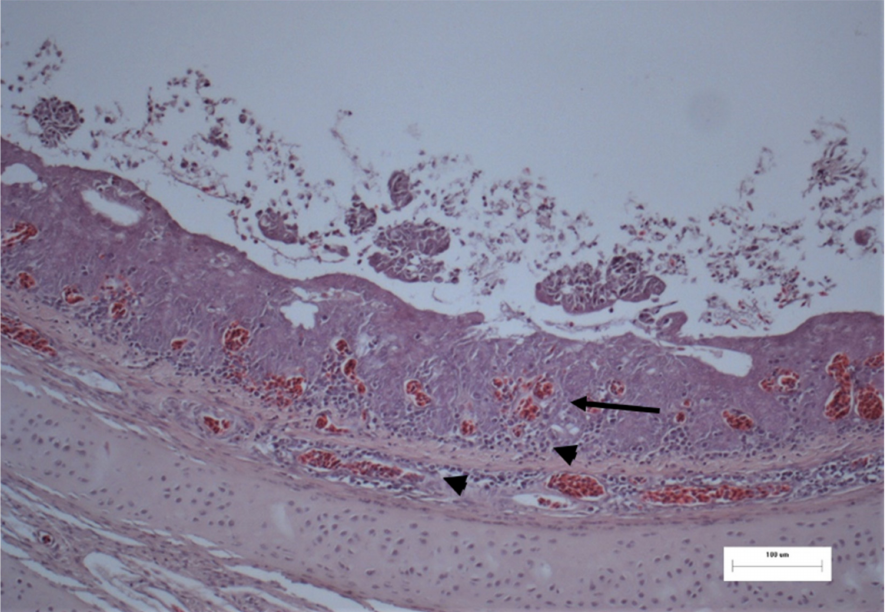
Figure 3. Histology of the trachea from a broiler chicken. Mucosa is thickened, epithelium is edematous, congested (arrow). Mucosa and submucosa are heavily infiltrated by lymphocytes and plasma cells (arrowhead). H.E. stain; M: 250 × .